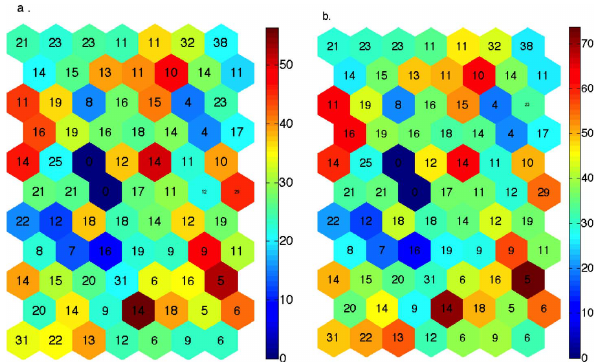
Figure 9. (a) Distribution of the neural map of (a) the average dif- ference in p CO 2 for each neuron represented by the colour bar. (b) The standard deviation (SD) in p CO 2 for each neuron repre- sented by the colour bar. For (a) and (b) , the numbers inside the neurons correspond to the number of data that construct the charac- teristics of the neuron.